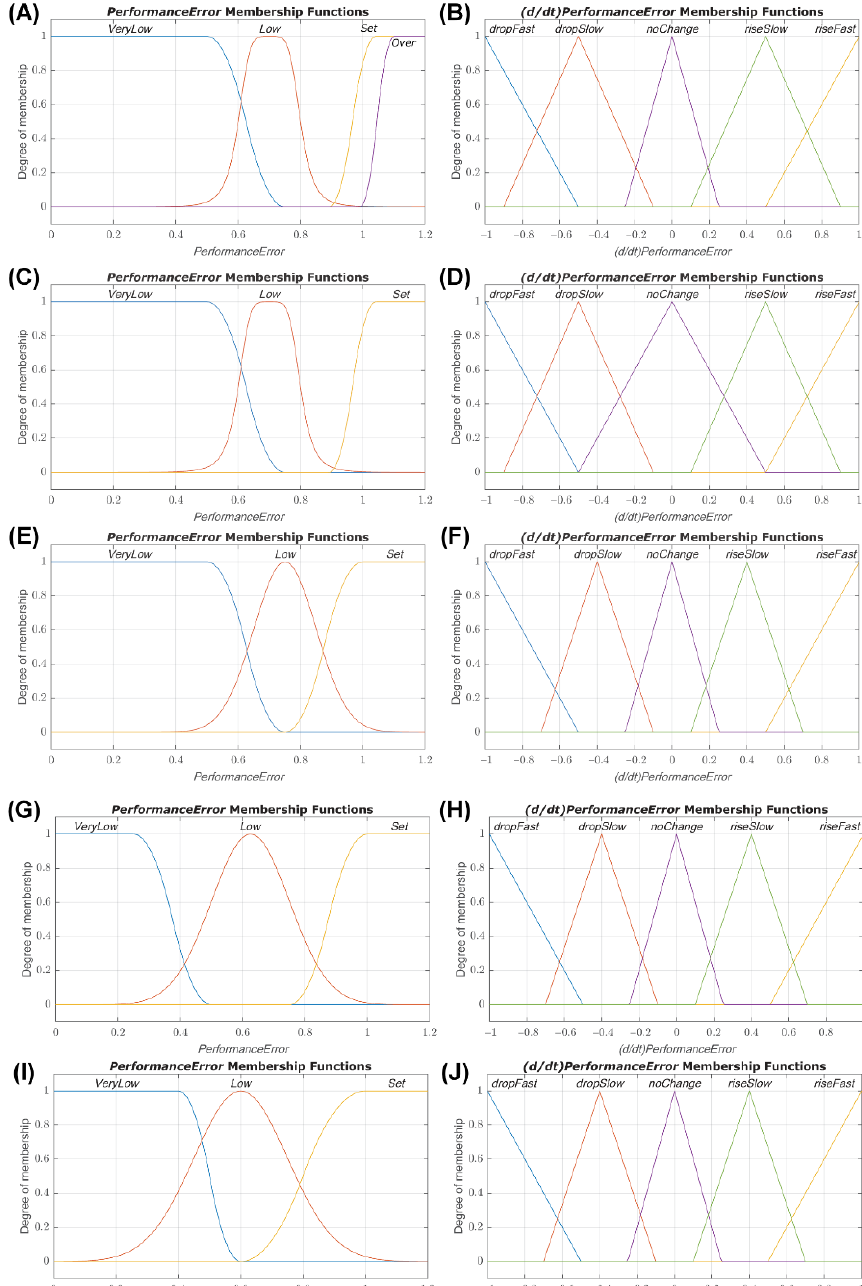
Figure 2. Membership function plots for dual-input fuzzy logic controllers. Plots of the PerformanceError and (d/dt)PerformanceError input membership functions for dual-input fuzzy logic controllers 1 ( A , B ), 2 ( C , D ), 3 ( E , F ), 4 ( G , H ), and 5 ( I , J ).